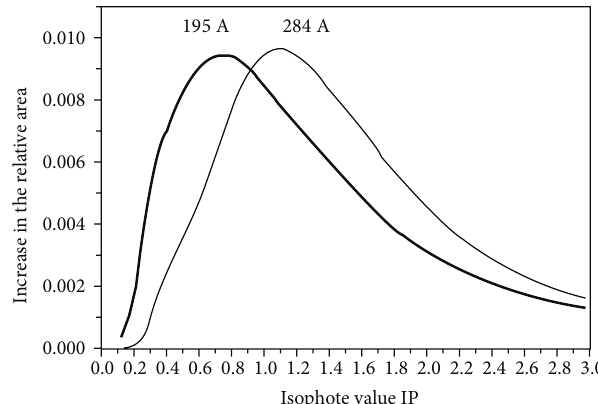
Figure 4: The increase in the relative area Δ𝑆 with increasing isophote value